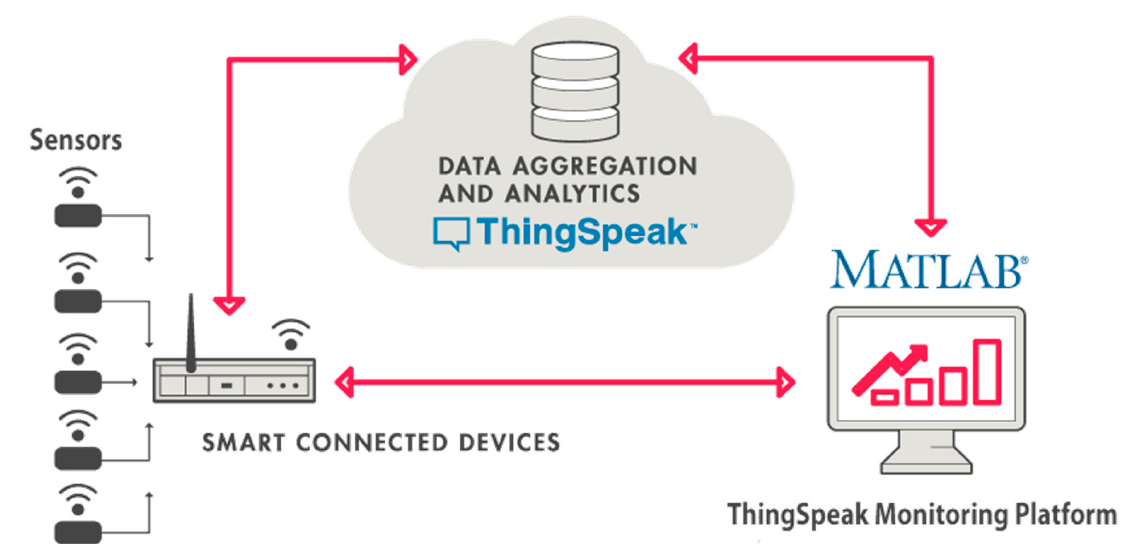
Figure 2. The architecture of IoT connectivity with ThingSpeak.